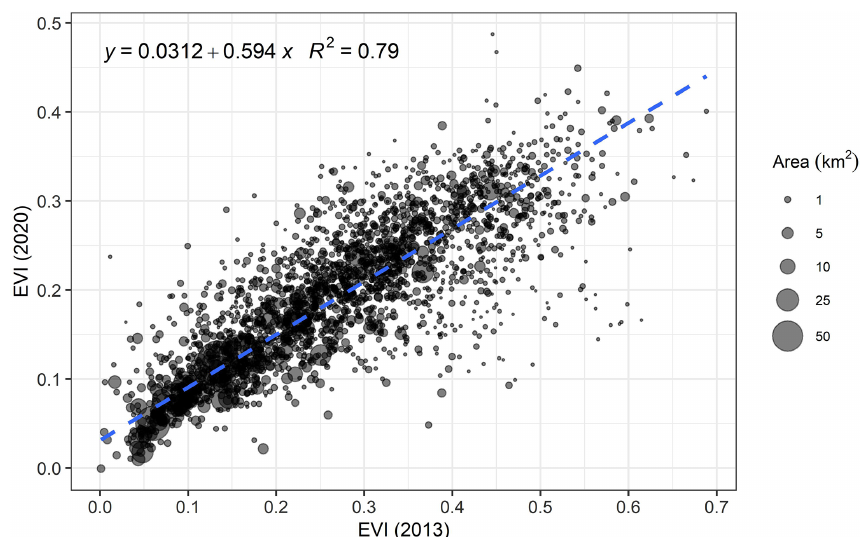
Figure 7. EVI values of PV power plants in 2020 vs. those in 2013 across China.